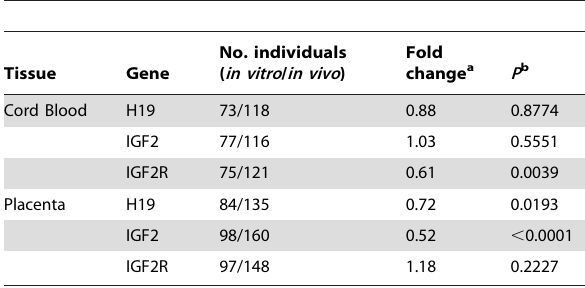
Table 5. Differences in transcript level between in vitro and in vivo